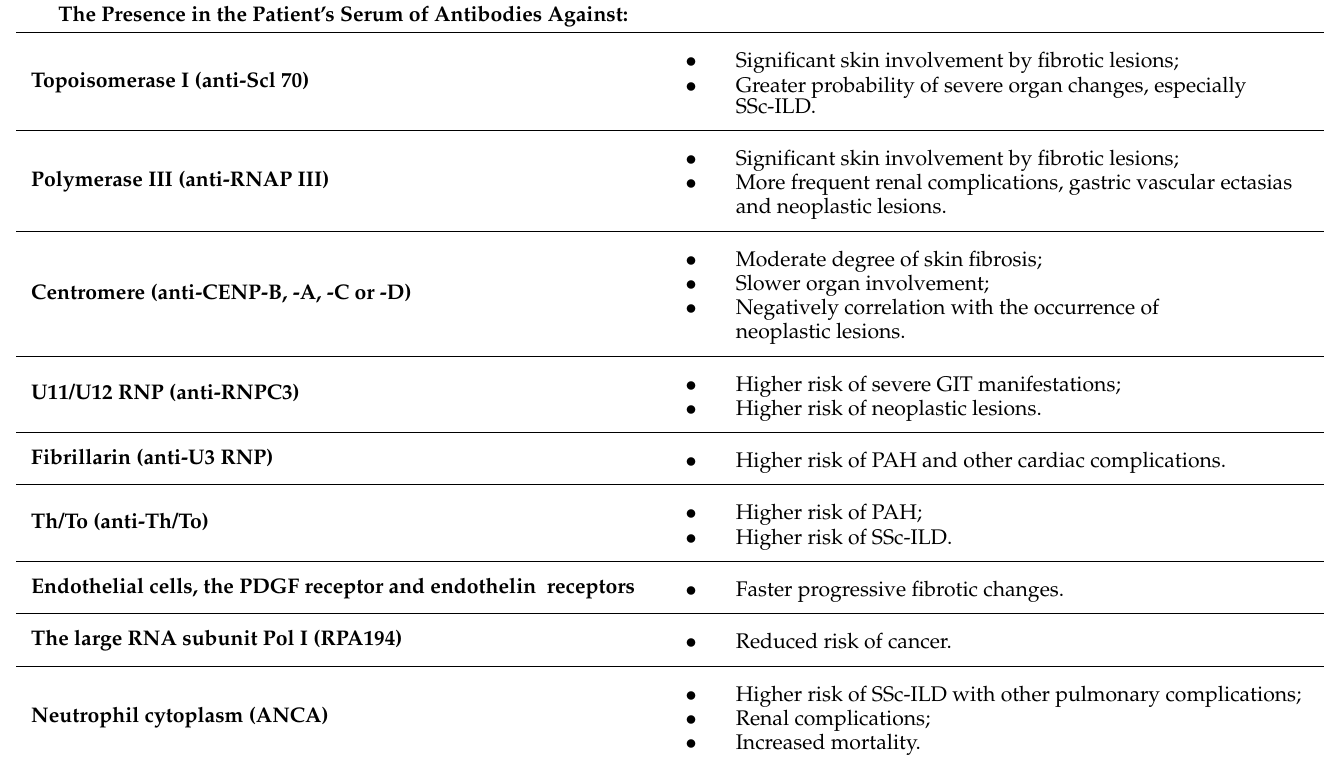
Table 3. Antibodies detected during the diagnosis of systemic